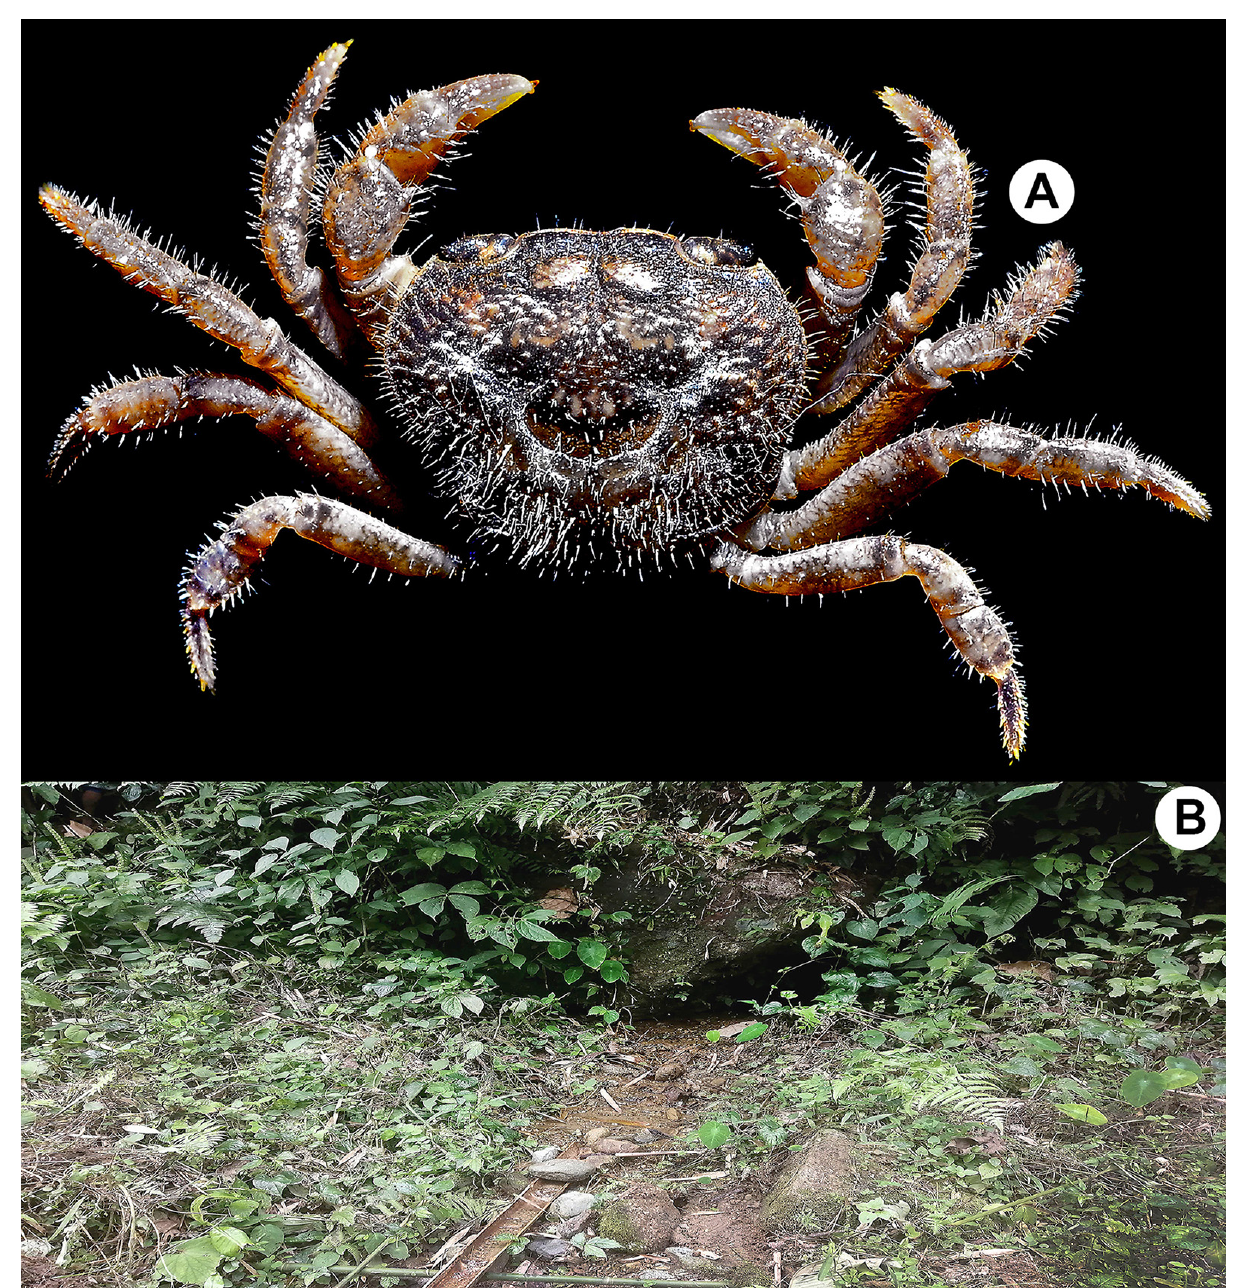
Figure 9. Coloration and habitat of Abormon praecalvum sp. nov. A , coloration of freshly preserved holotype male (10.2 × 8.5 mm) (ZSIK C.8610/2); B , dried stream at type locality,